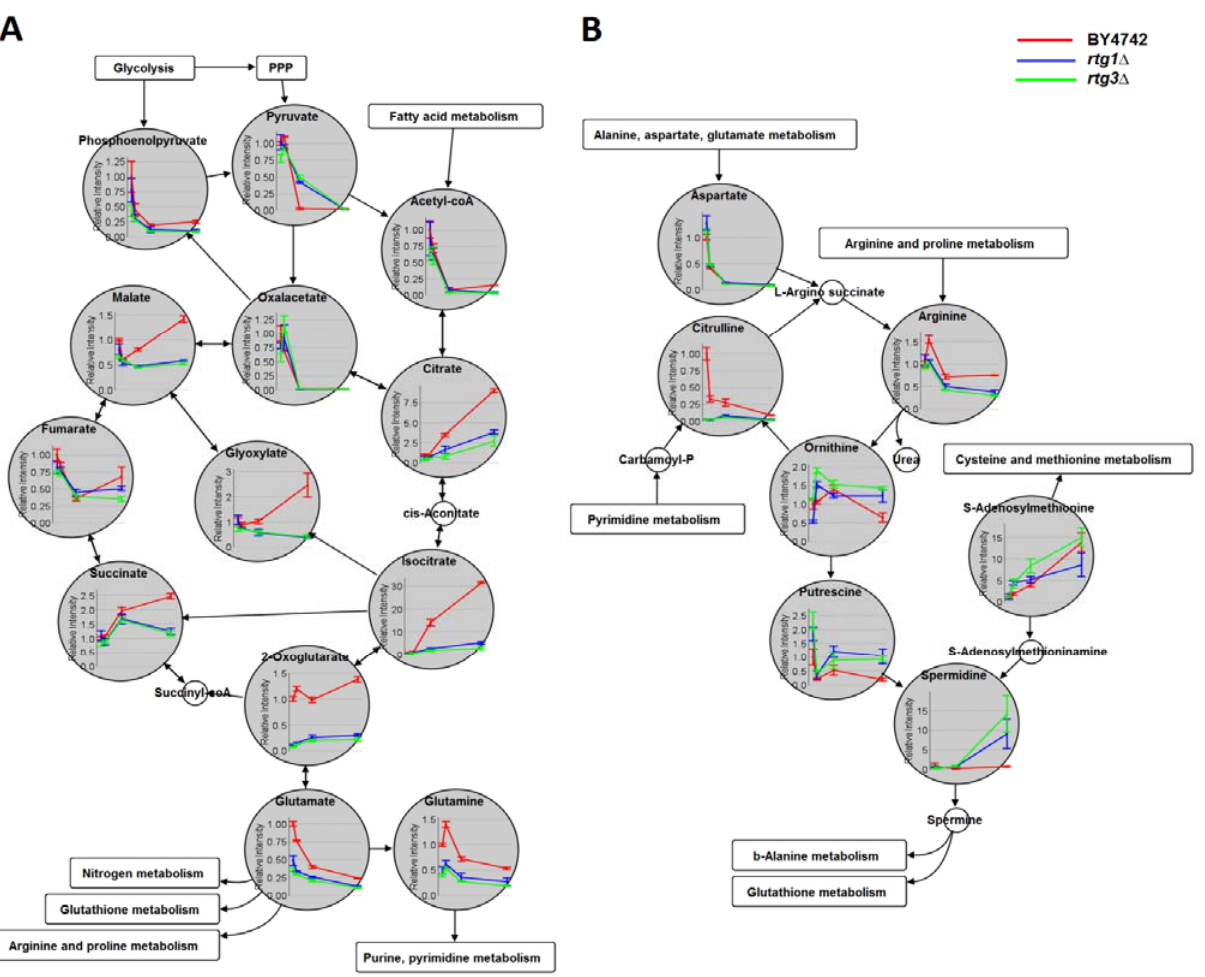
Figure 3. Time-course metabolic profiles of BY4742, rtg1 ∆ and rtg3 ∆ ( n = 3) in ( A ) the TCA/glyoxylate cycle and ( B ) the superpathway of polyamine biosynthesis, shown together with the neighboring metabolic pathways (PPP: pentose phosphate